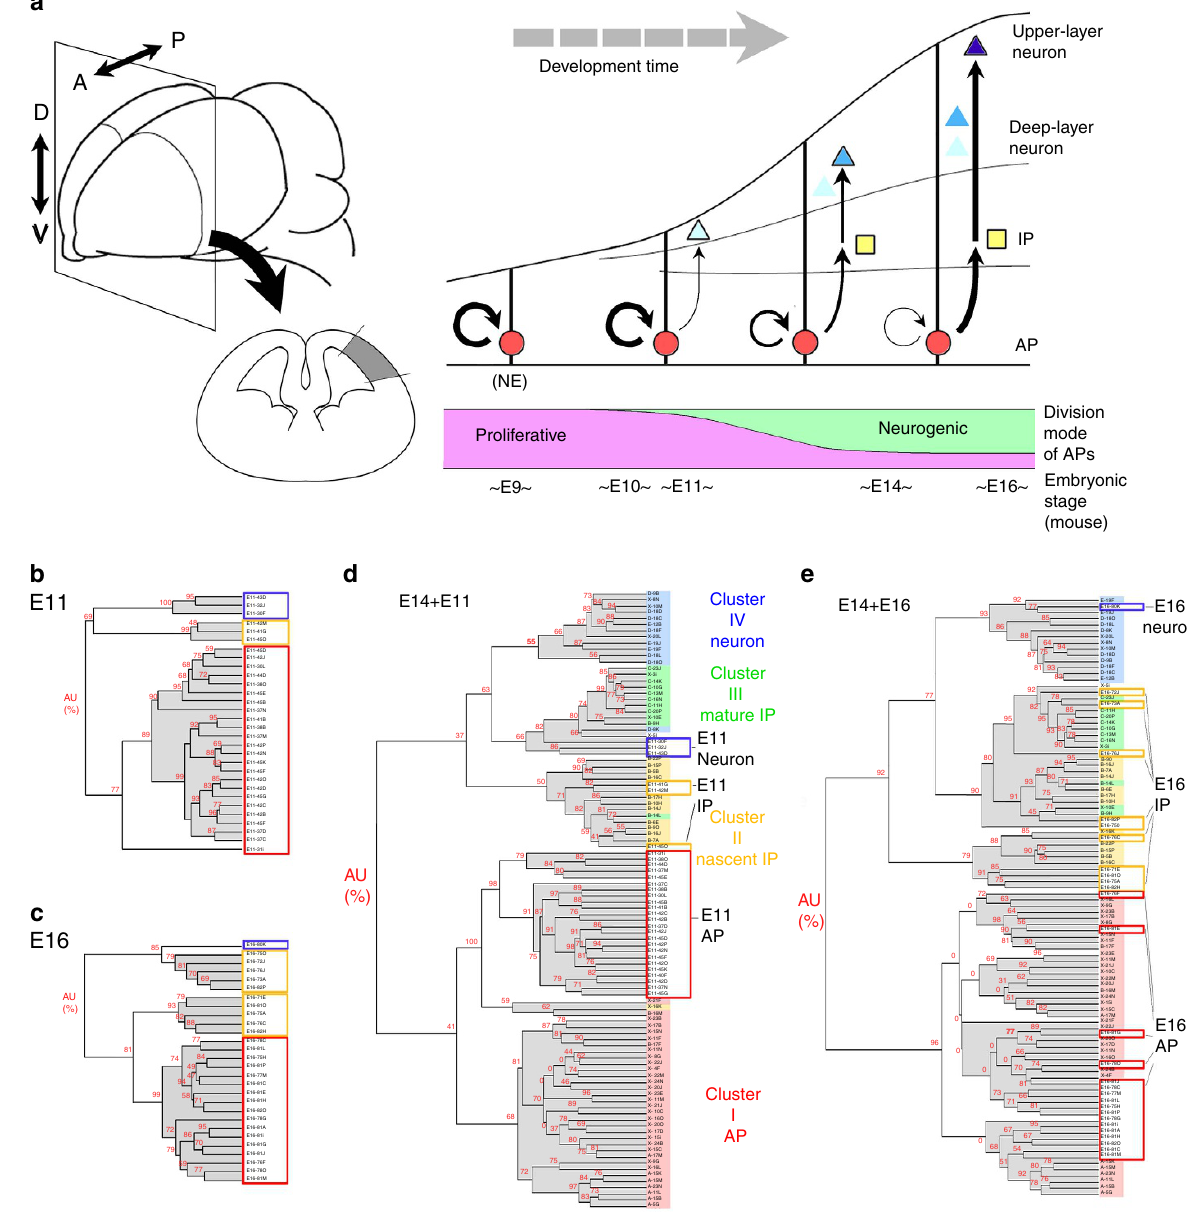
Figure 1 | Classification of cortical progenitor cells. ( a ) Scheme of mammalian cerebral development. Before onset of neurogenesis, APs (apical progenitor cells, neuroepithelial cells (NEs) at this stage) undergo proliferative symmetric division. After onset of neurogenesis, APs overtime undergo temporal progression with respect to two properties: division mode (proliferative versus neurogenic) and the fates of their differentiating progeny (deep- layer neurons versus upper-layer neurons). A, anterior; P, posterior; D, dorsal; V, ventral; IP, intermediate progenitor cell. ( b – e ) E14-based hierarchical clustering analysis of single-cell cDNA classifies E11- and E16-derived cortical progenitor cells. Clustering dendrograms show the results from the SigABC genes. In the dendrograms, each label represents a single cell, and the label colour indicates the cluster where it belongs. The values in red at the branches are AU (approximately unbiased) P values (%). The horizontal branch length represents the degree of dissimilarity in gene expression among the samples. See also Supplementary Figs